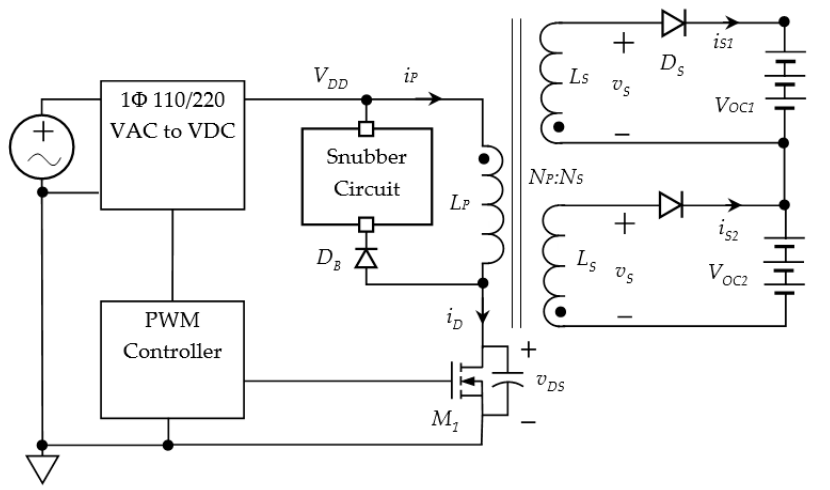
Figure 2. Multi-winding flyback converter.